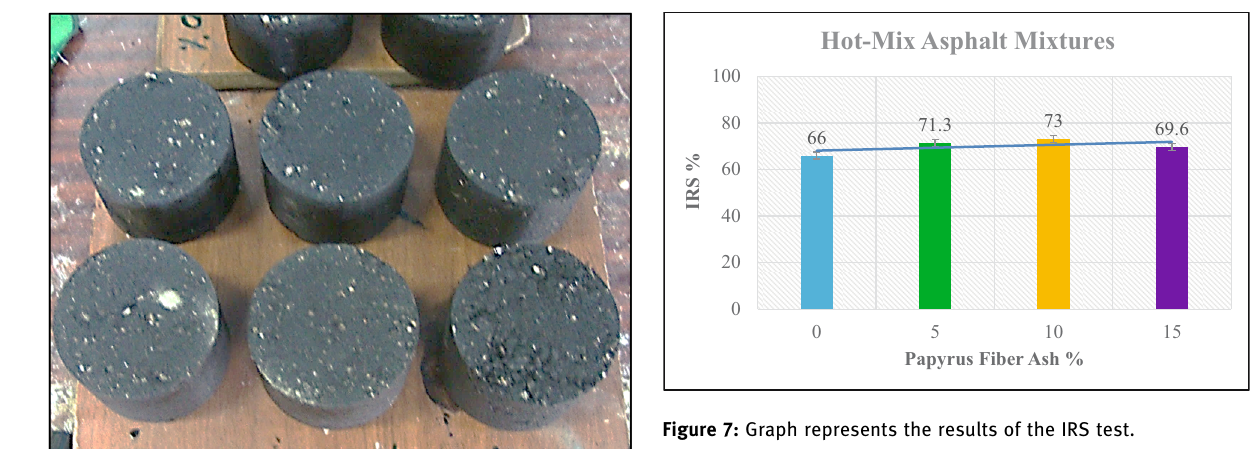
Figure 7: Graph represents the results of the IRS